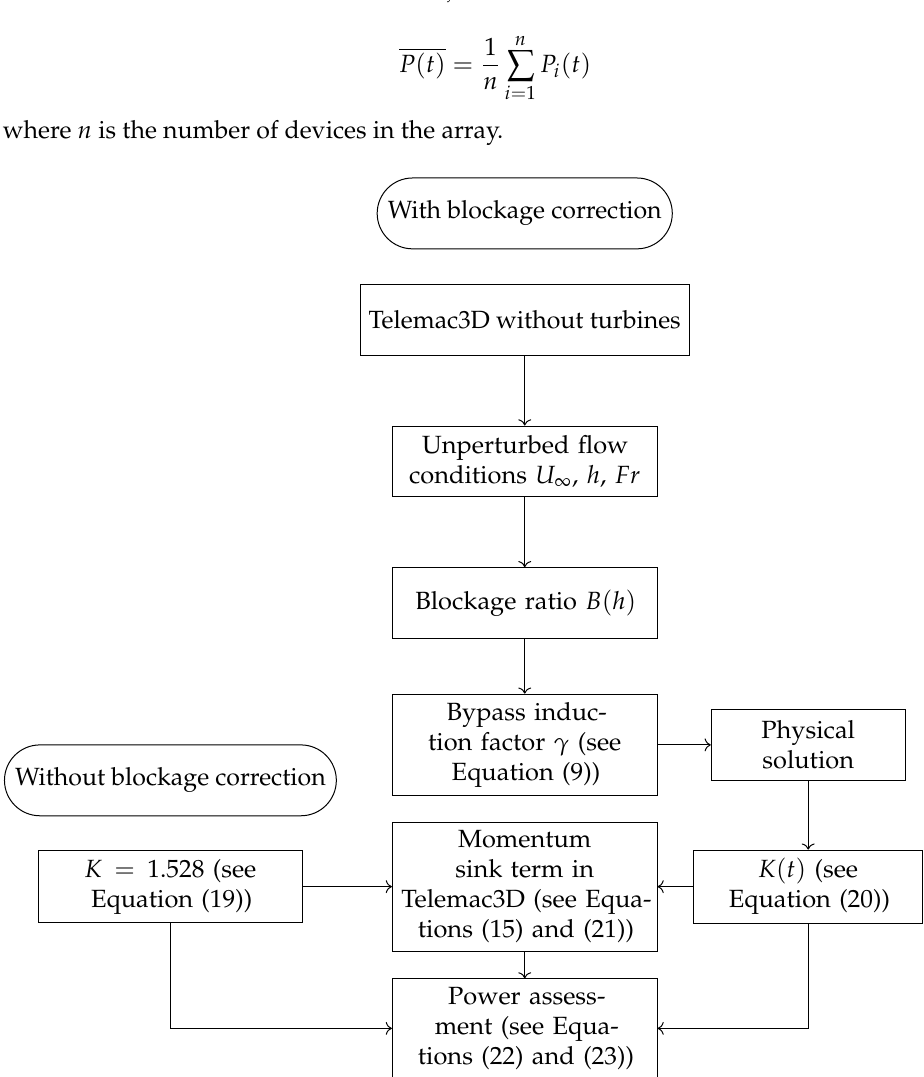
Figure 5. Methodology used in this